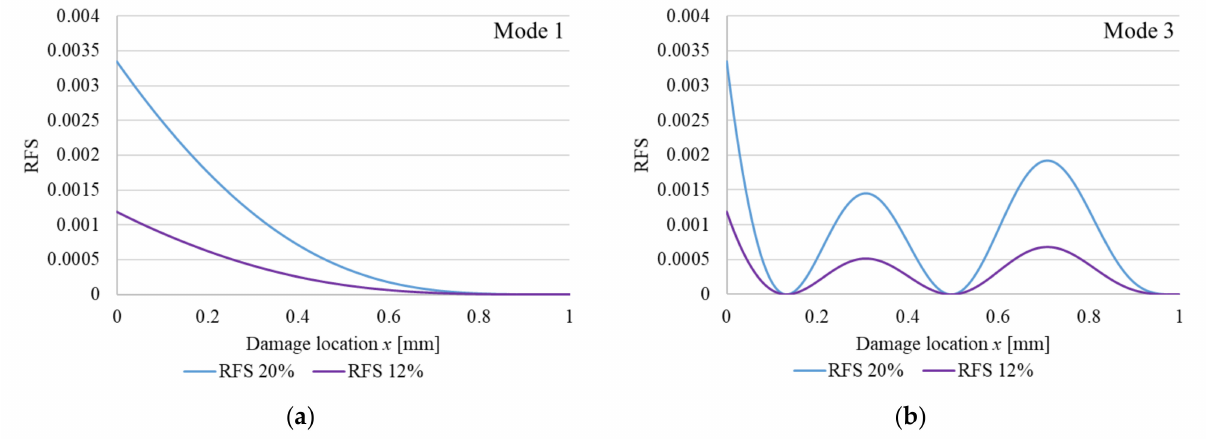
Figure 1. Plotted RFS functions for out-of-plain bending vibrations of a cantilever beam with perfect fixing: ( a ) vibration; mode 1; ( b ) vibration mode 3. The functions are plotted for a cross-section reduction of 12% and 20%,